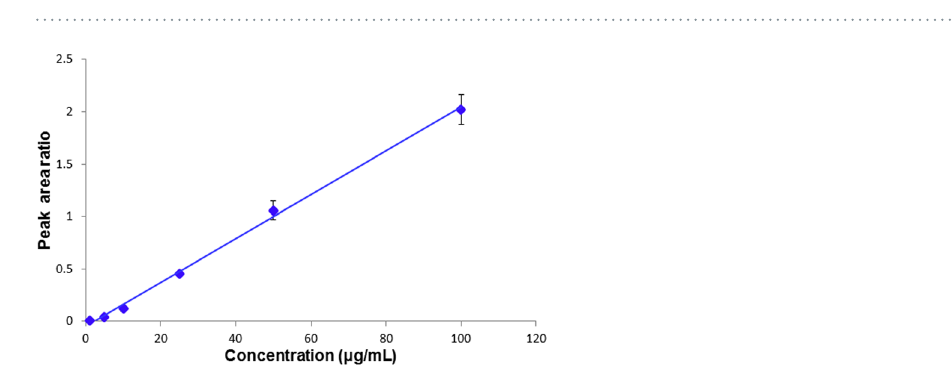
Figure 3. Typical mass spectra for ( A ) the analysis of ibuprofen spiked in human (100 μ g/mL) plasma after adding acetonitrile to precipitate the undesired components and [M + H] + signal of ibuprofen at m/z 207 could not be detectable; ( B ) the analysis of ibuprofen in human plasma under the optimized micro-labeling conditions. [M + H] + signals of ibuprofen (peak 1) and ibuprofen-d3 (peak 2) derivatives appear at m/z 354 and 357, respectively. The red line is due to the plasma blank and blue line is attributable to the plasma spiked with 100 and 35 μ g/mL of ibuprofen and ibuprofen-d3, respectively.